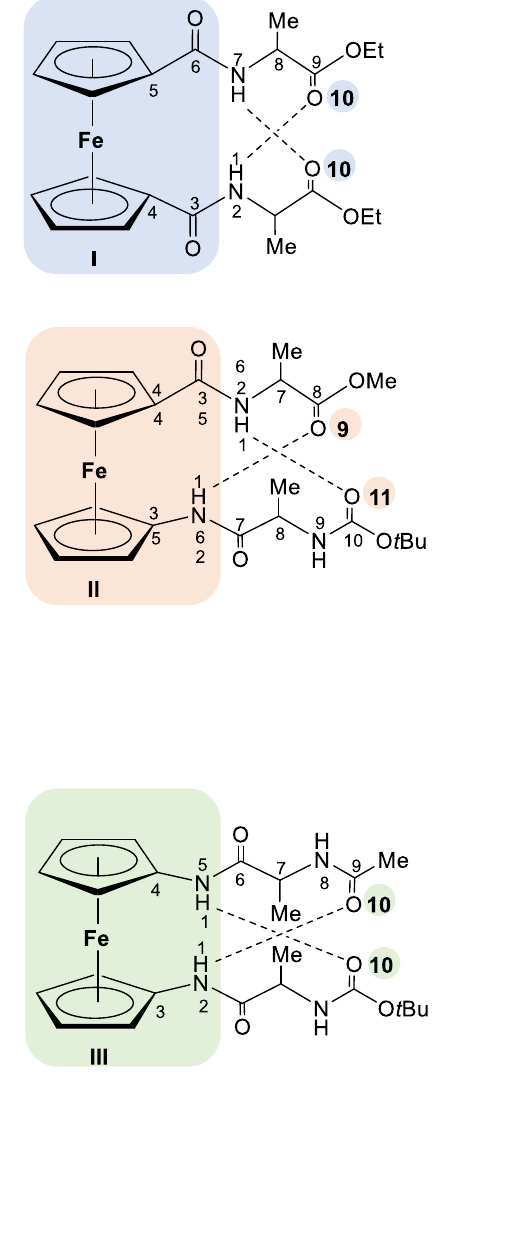
Figure 1. The hydrogen-bonding patterns in peptidomimetics containing turn-inducing ferrocene templates −CO−Fn−CO− ( I and IV ), −NH−Fn−CO− ( II and V ), and −NH−Fn−NH − ( III and VI ).